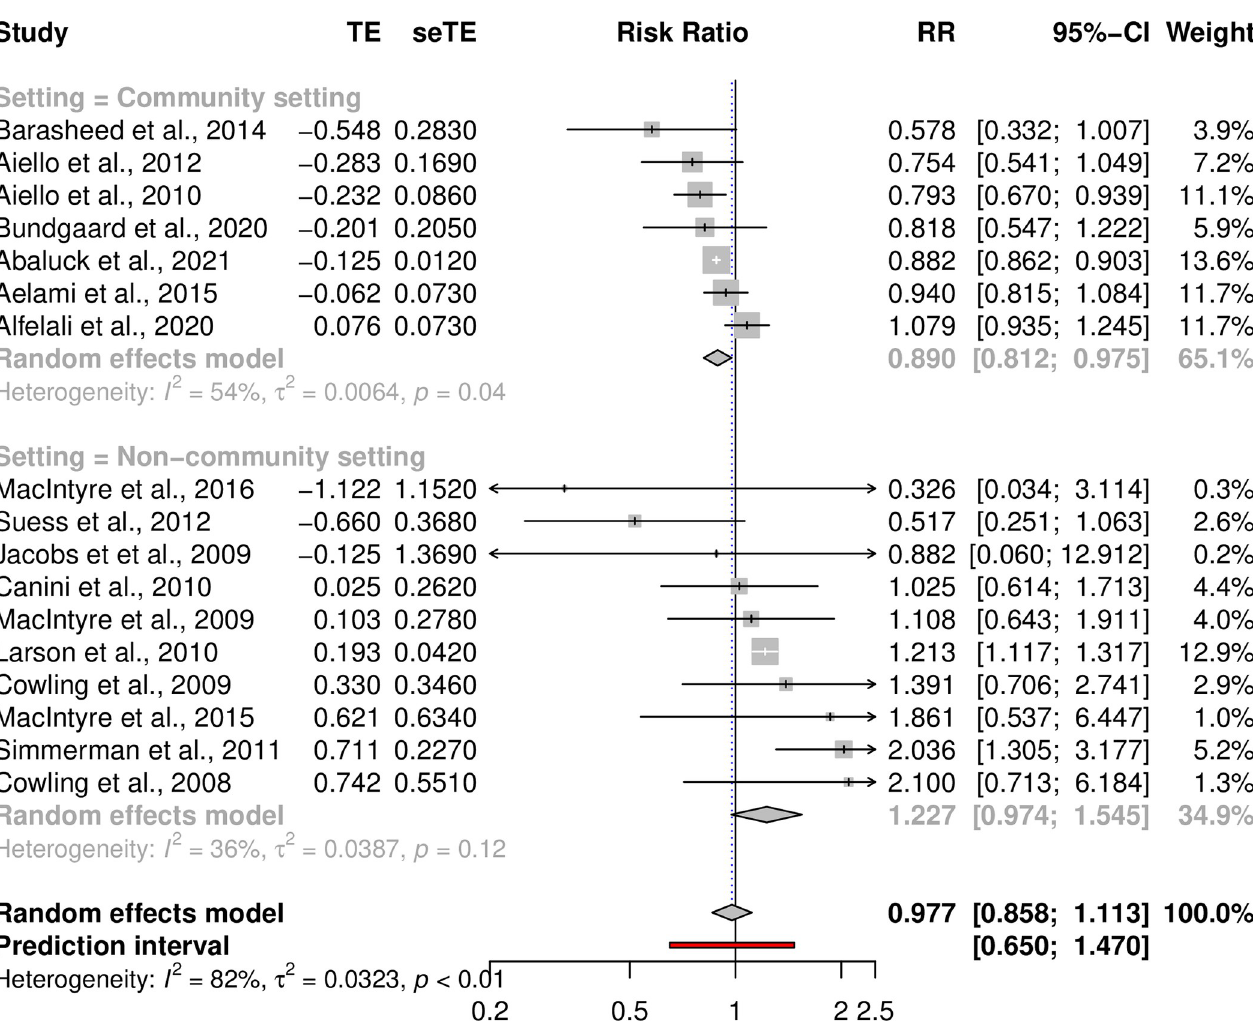
Fig 3. Effect of face masks across 17 studies with covariate unadjusted risk ratio estimates and subgroup analysis by community setting. Pooled effects across 17 studies of unadjusted risk ratio estimates for which the numbers of infected for each intervention arm were available using a random-effects meta- analysis model. TE = treatment effect and seTE = standard error of treatment effect, p-value = ξ 2 is the p-value for the test of homogeneity of study-specific effect